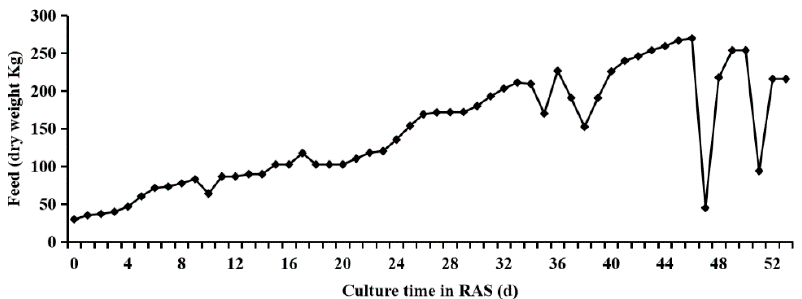
Figure 4. Changes in daily feed amount during the recirculating aquaculture period.